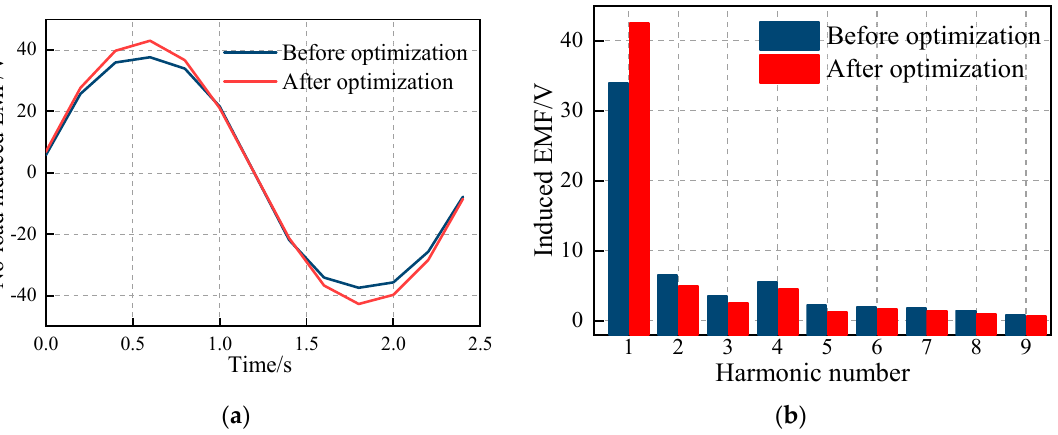
Figure 17. Comparison of the no-load induced EMF of claw pole rotor before and after optimization. ( a ) Comparison of the no-load induced EMF curves; ( b ) comparison of the no-load induced EMF harmonic